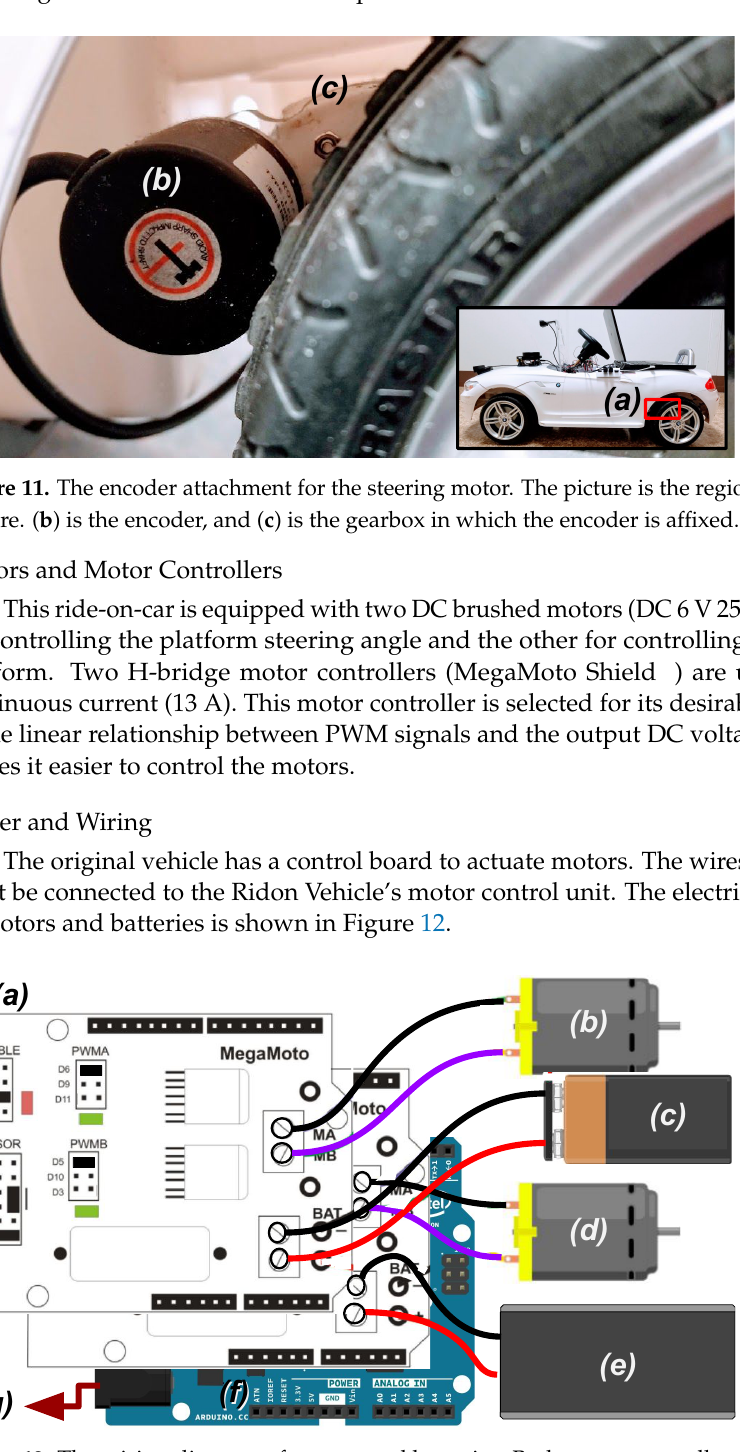
Figure 12. The wiring diagram of motors and batteries. Both motor controllers are set as the Meg- aMoto H-bridge mode to drive DC brushed motors both forward and reverse. ( a ) The motor controller ( b ) The steering motor. ( c ) 9 V rechargeable battery. ( d ) The driving motor. ( e ) 9.6 V rechargeable battery. ( f ) The microcontroller board ( g ) The USB port to connect to the main laptop computer. Two MegaMoto H-bridge motor controllers are used to drive the DC brushed motors in both forward and reverse motions. A 9 V rechargeable battery is used for the